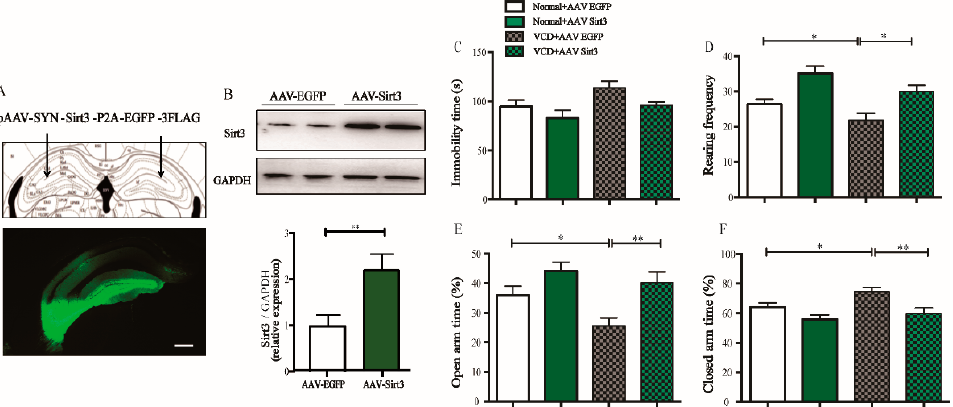
Figure 5. Overexpression of Sirt3 exhibits antidepressant- and anxiolytic-like effects similar to kaempferol. ( A ) The schematic diagram (upper panel) of the location for viral microinjection with a pAAV-SYN-Sirt3-P2A-eGFP-3FLAG (AAV-Sirt3) or a control pAAV-SYN-eGFP-3FLAG (AAV-eGFP) and fluorescence images (lower panel) showing efficient expression of AAV-Sirt3 vector in the hippocampus; Scale bar = 200 µm ( n = 12–13 per group). ( B ) Representative images of Western blots (upper panel) and quantification of Sirt3 expression (lower panel) showing that AAV-Sirt3 injection increased Sirt3 expression in the hippocampus ( n = 4 per group). ( C ) Immobility time in FST. ( D ) Rearing frequency in OFT. ( E , F ) Percentage of time spent in the open arms ( E ) and time spent in the closed arms in EPM. ( F ) Data are represented as mean ± SEM, two-way ANOVA analysis with Sidak’s multiple comparisons test: * p < 0.05, ** p < 0.01.